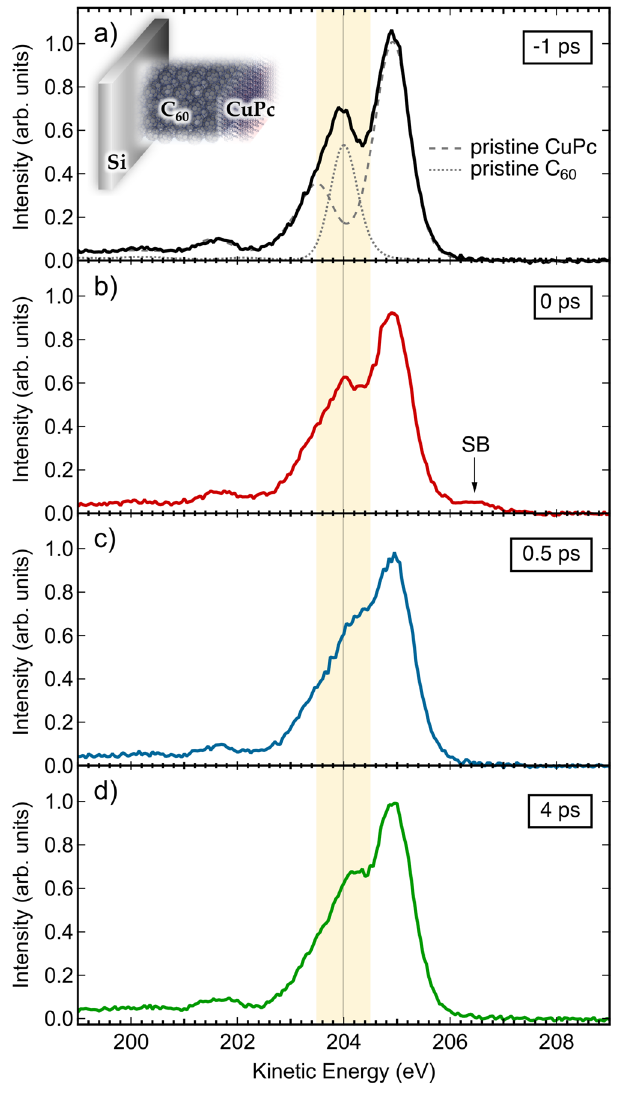
Fig. 2 Representative time-resolved C 1 s -XPS spectra measured at different pump – probe delays. Time-resolved C 1 s -XPS spectra of a planar heterojunction consisting of ~1 – 2 ML of CuPc atop a thin fi lm of C 60 . Optical pump – X-ray probe time delays vary between − 1 and 4 ps as indicated. a The spectrum where the probe pulse arrives 1 ps before the pump pulse. b Depicts the spectra where both pulses are overlapping in time, and in c and d the spectra are shown when the probe pulse arrives 0.5 and 4 ps after the pump pulse. a The spectra of pristine CuPc and C 60 are overlaid as dashed and dotted lines, respectively. The vertical gray line indicates the initial (ground state) position of the C 1 s line of C 60 , which dominates the spectrum within the yellow-shaded energy range. SB marks a sideband induced by the laser-assisted photoelectric effect near zero pump – probe